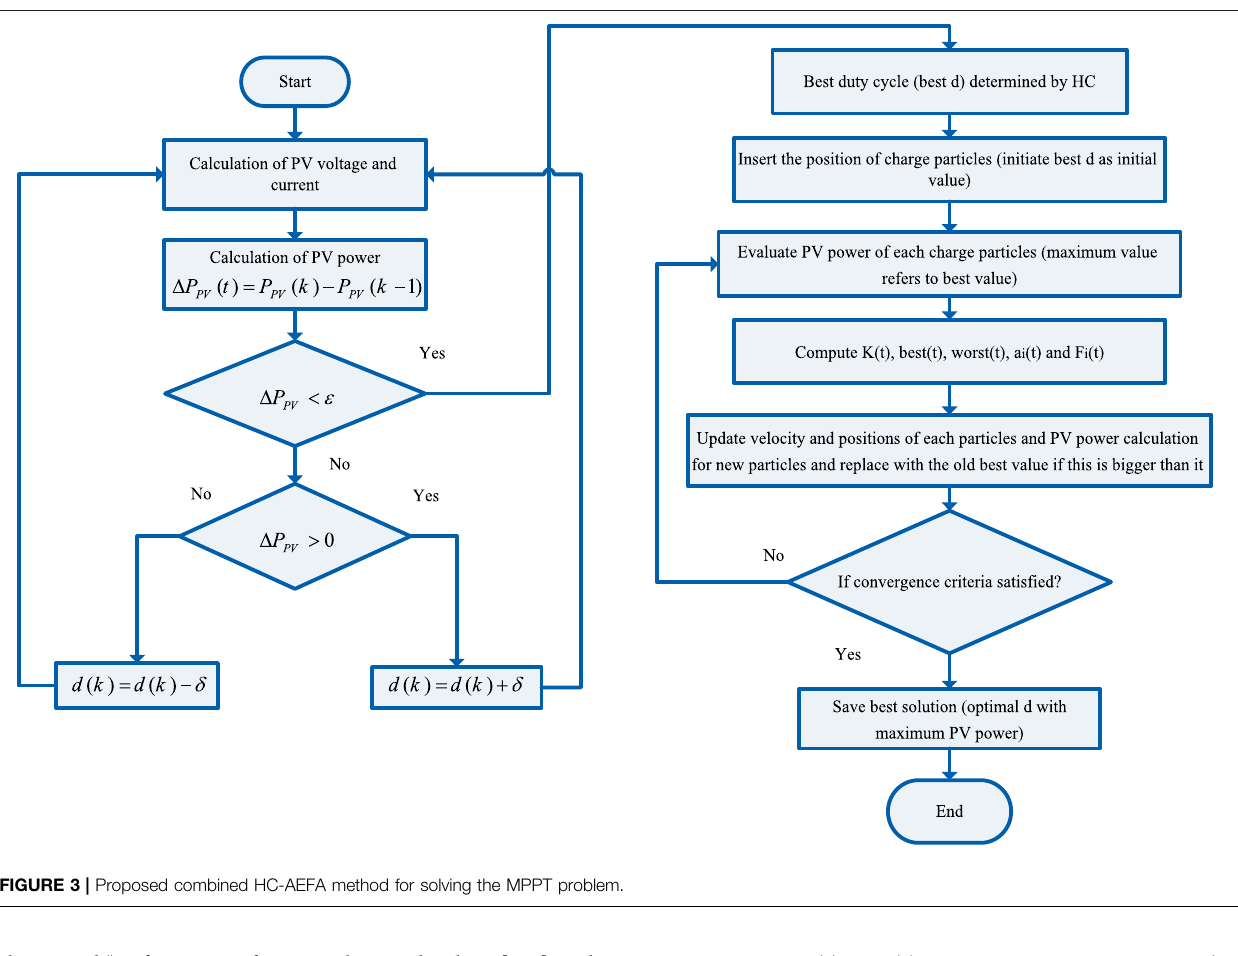
FIGURE 3 | Proposed combined HC-AEFA method for solving the MPPT